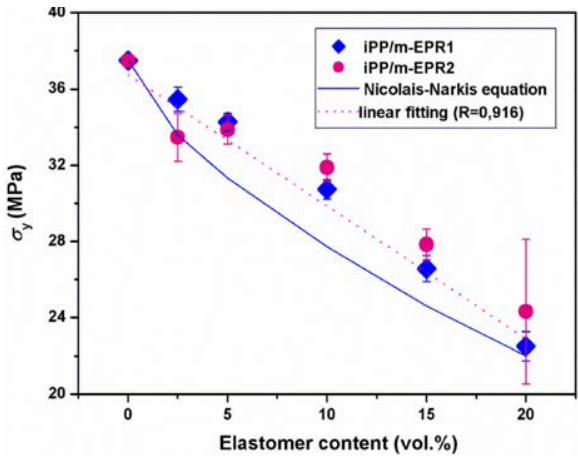
Figure 3. Tensile strength at yield of the iPP/m-EPR blends in de- pendence on volume content of added elastomers and Nico- lais-Narkis model for yield strength